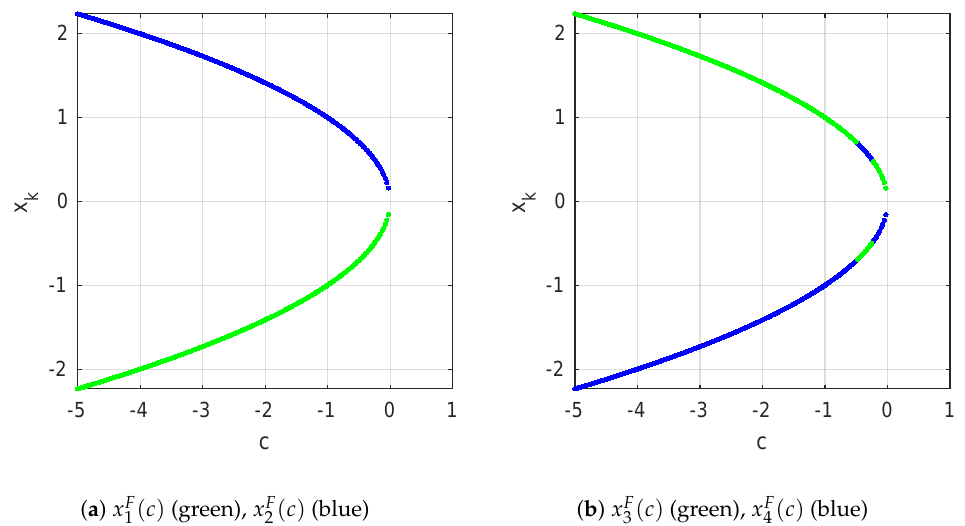
Figure 1. Bifurcation diagrams for the fixed points of Traub’s method.